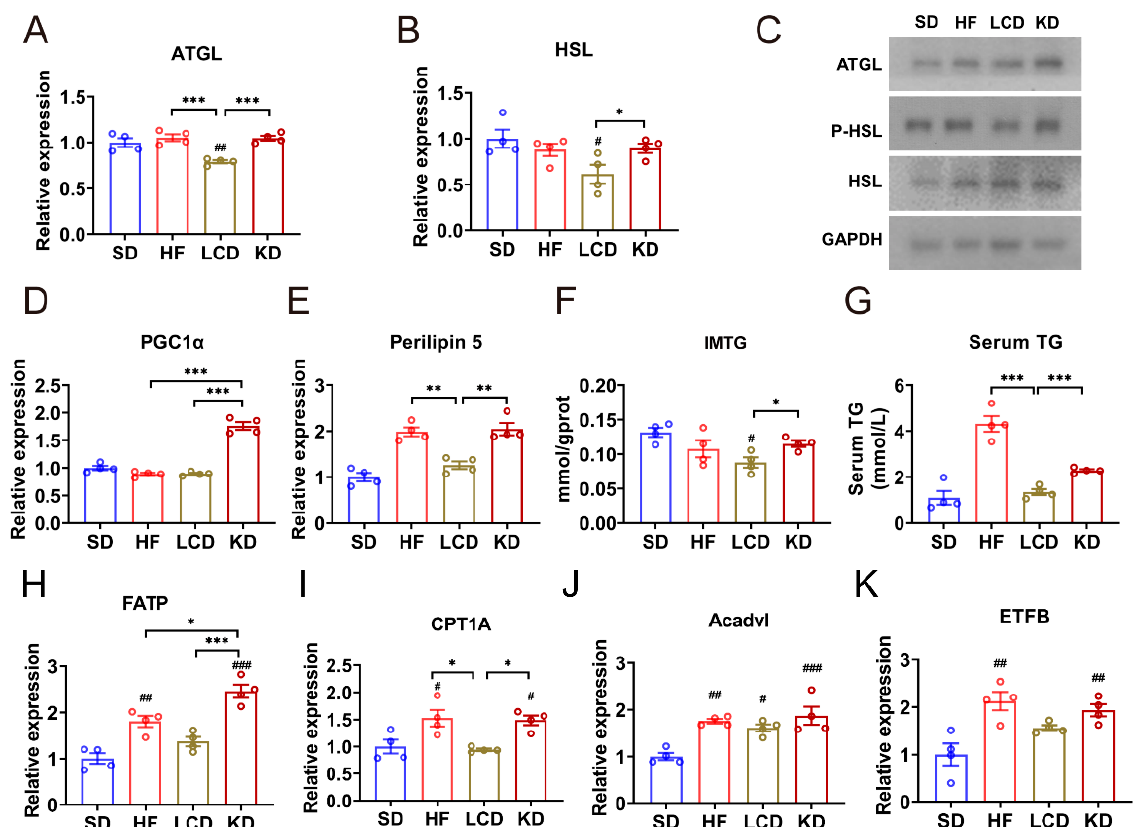
Figure 4. Ketogenic diet increased lipolysis in skeletal muscle. ( A , B ) mRNA levels of ( A ) ATGL and ( B ) HSL in the GAS muscle of mice. ( C ) Western blots of ATG, P-HSL, and HSL in the GAS muscle of mice. ( D , E ) mRNA levels of ( D ) PGC1 α and ( E ) Perilipin5 in the GAS muscle of mice. ( F ) Triglyceride content in the GAS muscle of mice. ( G ) Serum triglyceride content in mice of different treatments. ( H – K ) mRNA levels of ( H ) FATP, ( I ) CPT1A, ( J ) Acadvl, and ( K ) ETFB in the GAS muscle of mice. Means ± SEM are shown. # p < 0.05, ## p < 0.01, ### p < 0.001 versus the standard diet group. * p < 0.05, ** p < 0.01, *** p < 0.001 di ff erences between groups.